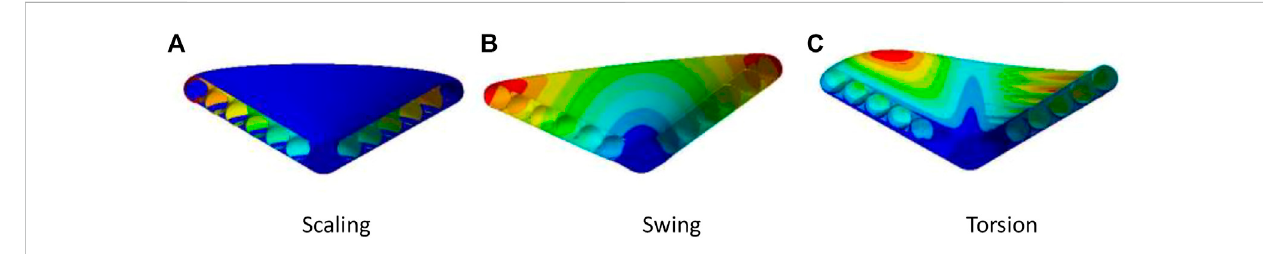
FIGURE 16 Typical modes of the fl exible in fl atable structure. (A) Scaling (B) Swing (C)